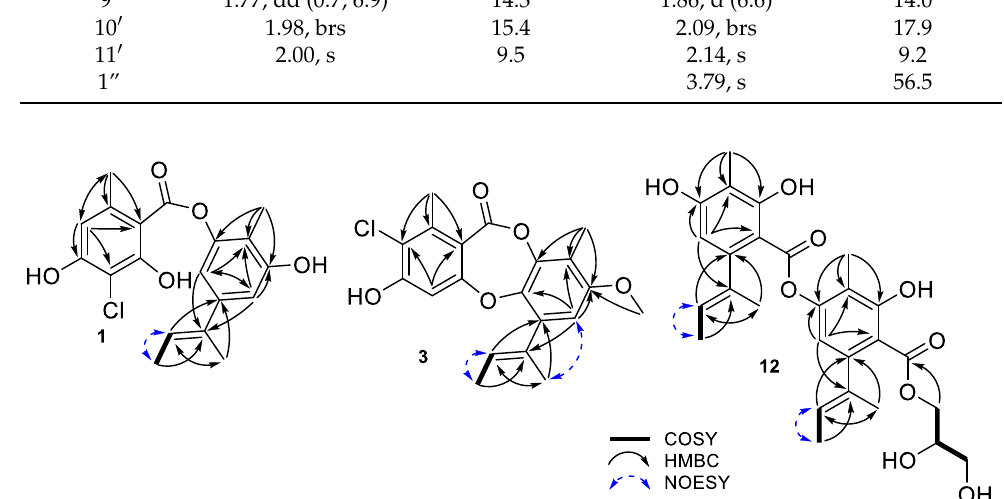
Figure S5). A carboxyl and 14 sp 2 carbons accounting for eight out of ten indices of hydro- gen deficiency indicated that 1 possesses a bicyclic skeleton (depside structure). The 1 H and 13 C NMR spectroscopic data of 1 quite resembled those of 2 (Figures S2, S25 and S26) except for the absence of an aromatic proton (H-5), and an increase in the molecular weight of 34 Da in 1, compared with that in 2, indicating 1 was a mono-chlorine-substi- tuted analog of 2 . Further detailed analysis of 2D NMR data of 1 (Figures S6 – S9) suggested the chlorine atom was substituted at the C-5 position of the ring A (Figure 2), and the structure of 1 was determined as 5-chlorodecarboxyunguidepside A and named un- guidepside C.